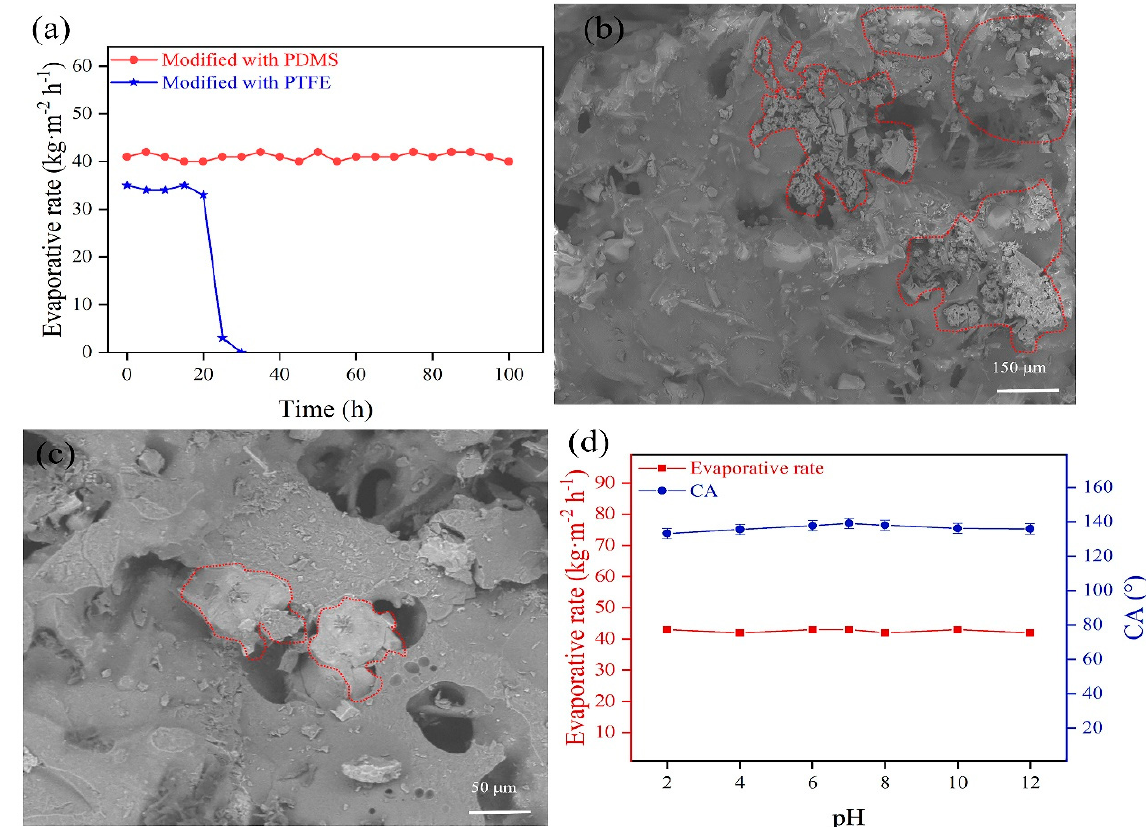
Figure 5. ( a ) Working stability of ceramic aeration membranes; ( b , c ) Membrane surface of failure of PTFE-ceramic membrane; ( d ) Chemical stability of PDMS-ceramic membrane.